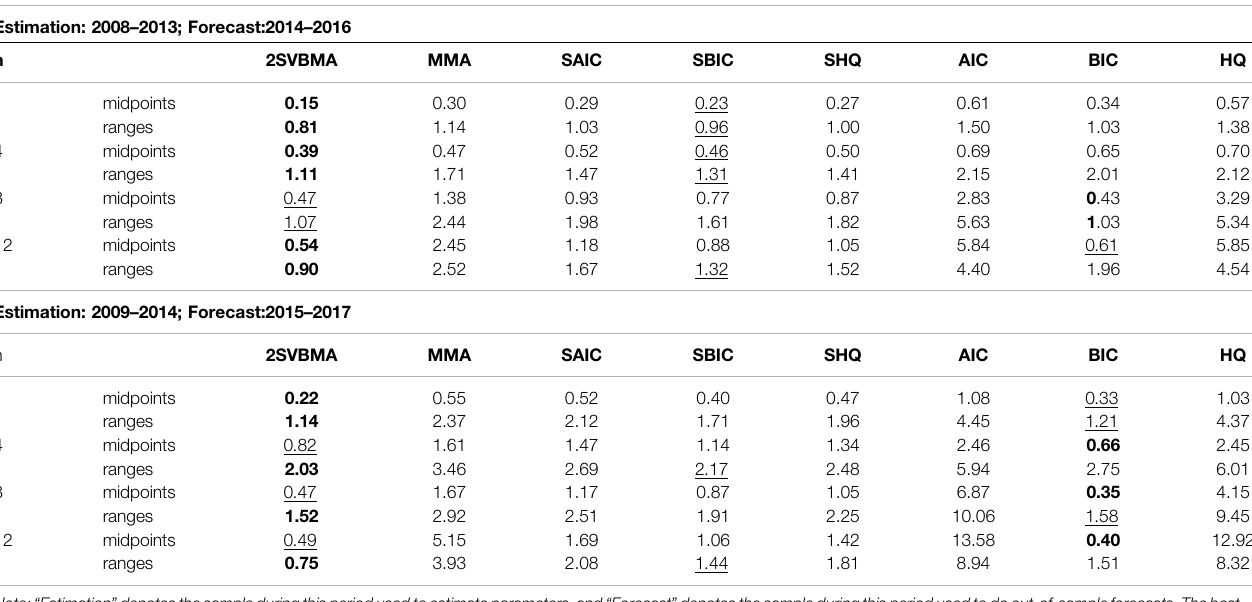
TABLE 5 | MSPE (10 − 2 ) of the recursive prediction for interval-valued crude oil prices (II). Estimation: 2008 – 2013; Forecast:2014 –